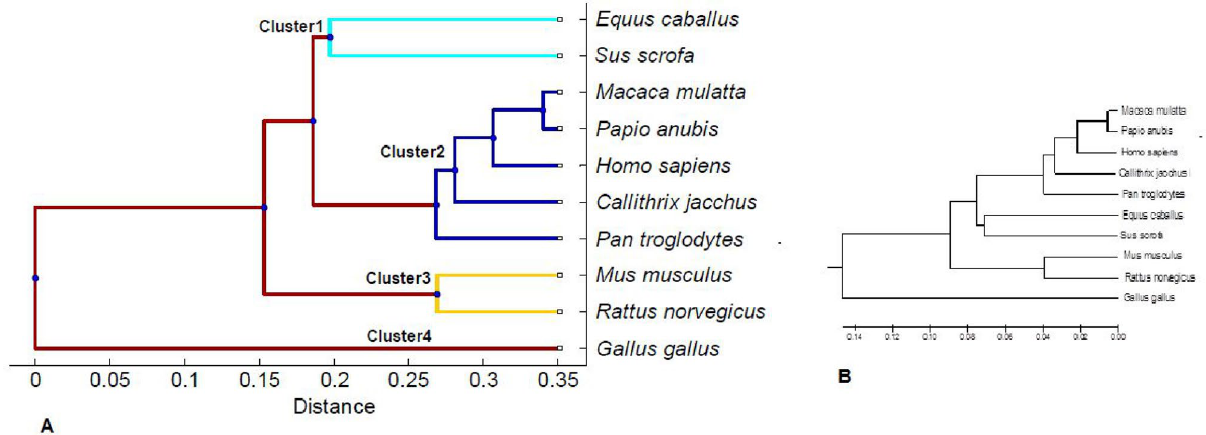
Figure 5. The phylogenetic tree of the hemoglobin coding sequences. ( A ) Phylogenetic tree is constructed with our algorithm (Alignment Free method). The similar sequences are grouped into cluster. Clusters are shown with different colours. ( B ) Phylogenetic tree using clustalW (Alignment based